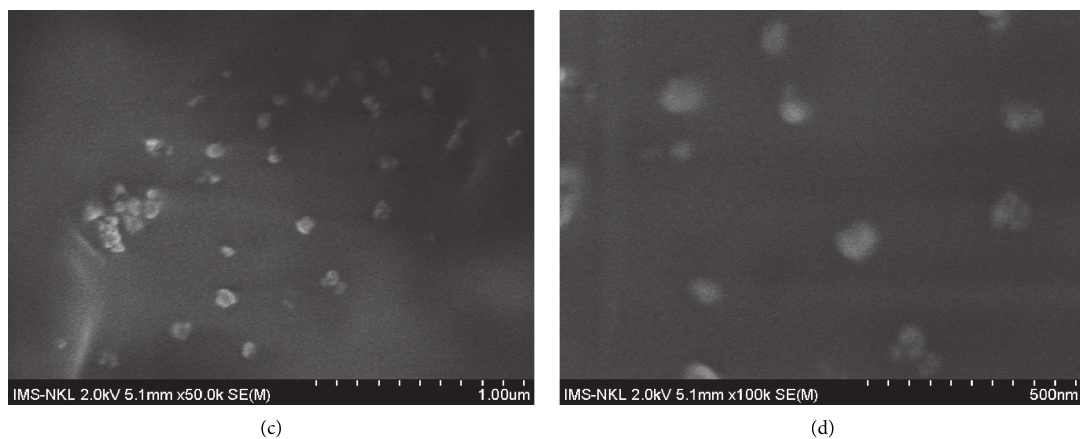
Figure 8: FESEM images of acrylic/2 wt.% u-ZrO 2 (a, b) and acrylic/2 wt.% m-ZrO 2 -3 (c, d)